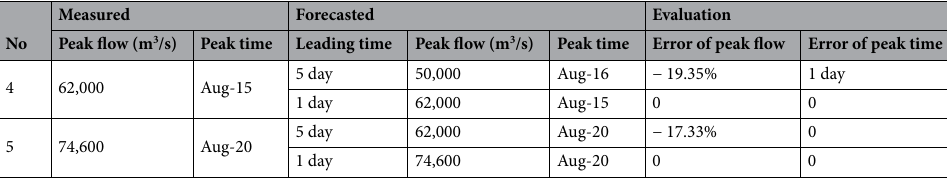
Table 1. Quantitative forecast performance during 4th and 5th floods in 2020.